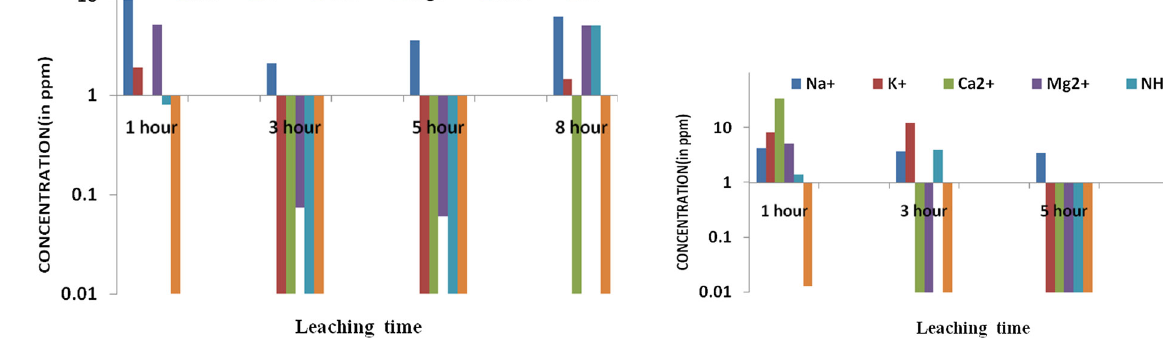
Fig. 6 Change in concentration of cations (in ppm) in aqueous leachates of Ledo overburden (LOB-15B) with leaching time (in hour) at 25 (cid:3)